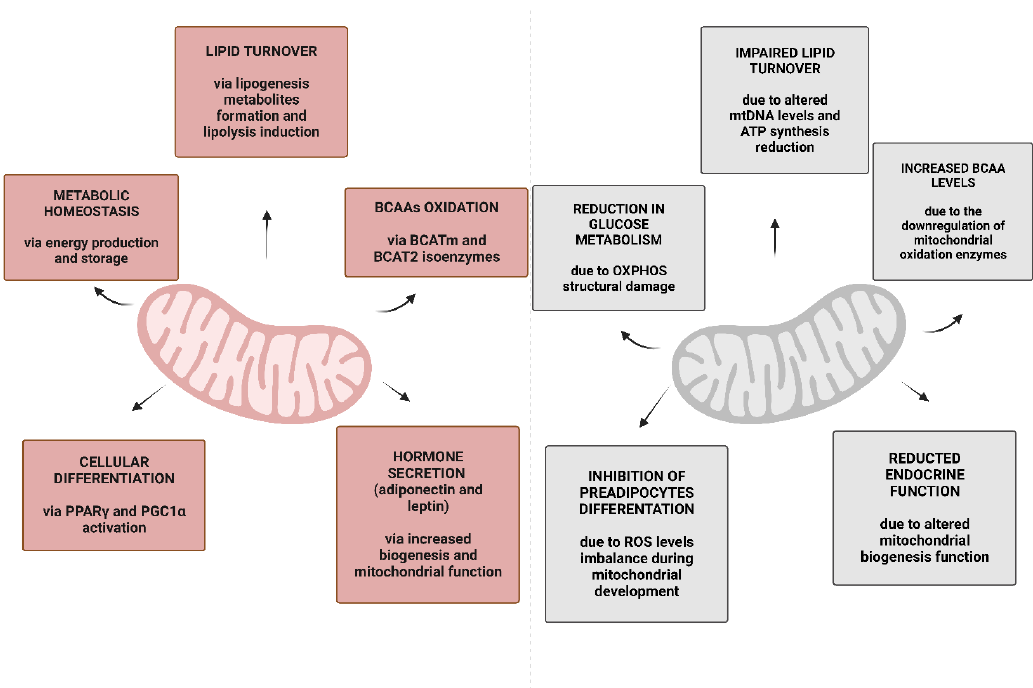
Figure 2. Physiological functions of WAT mitochondria and common impairments in obesity. The left panel (in pink) refers to the physiological condition where some of the main functions of WAT mitochondria are presented. In the right panel (in grey), the same functions are impaired in obesity. Created with BioRender.com (accessed on 13 March 2023). Abbreviations: BCAAs, branched-chain amino acids; BCAT, branche- chain amino acid aminotransferase; OXPHOS, oxidative phosphorylation; PGC-1α, peroxisome proliferator-activated receptor gamma coactivator-1α; PPARγ, peroxisome proliferator activated receptor-γ; ROS, reactive oxygen species.